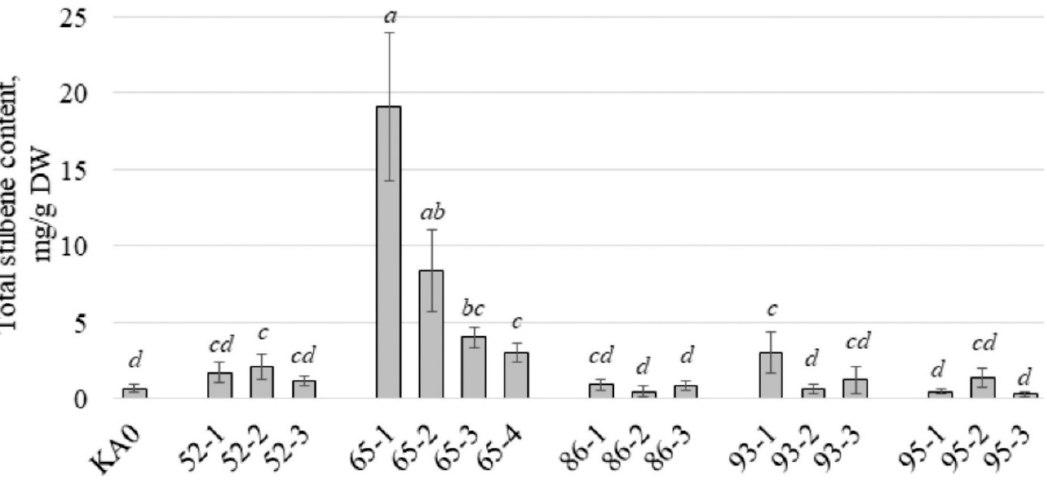
Figure 2. Total stilbene content in the cell lines of Vitis amurensis transformed with the VaCML52 , VaCML65 , VaCML86 , VaCML93 , or VaCML95 genes in mg per g of the dry weight (DW). KA0—control cell line transformed with the empty vector harboring only npt II selective marker; 52-1, 2, 3—cell lines transformed with the VaCML52 gene; 65-1, 2, 3, 4—cell lines transformed with the VaCML65 gene; 86-1, 2, 3—cell lines transformed with the VaCML86 gene; 93-1, 2, 3—cell lines transformed with the VaCML93 gene; 95-1, 2, 3—cell lines transformed with the VaCML95 gene. Means followed by the same letter were not different using one-way analysis of variance (ANOVA), followed by the Tukey HSD multiple comparison test (three independent experiments with two technical replicates). p < 0.05 was considered statistically significant.